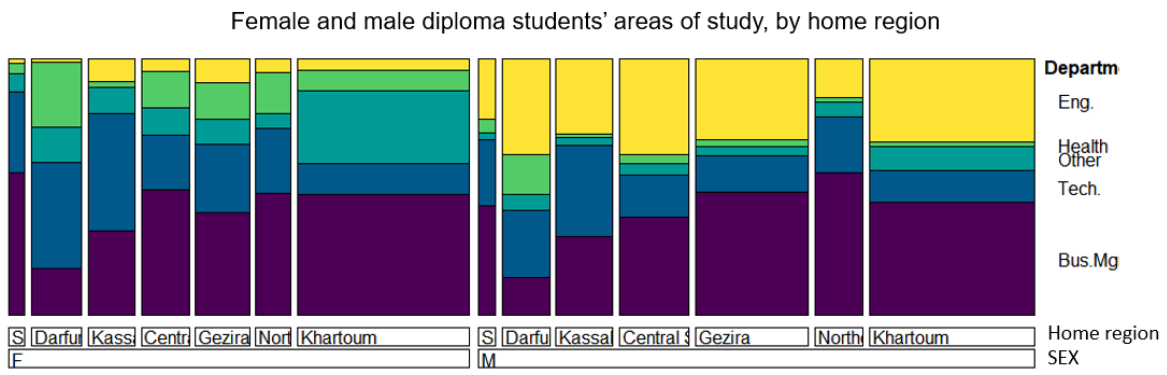
Figure 27. Double-decker plot of department category distributions by home region, for entering female and male diploma students.